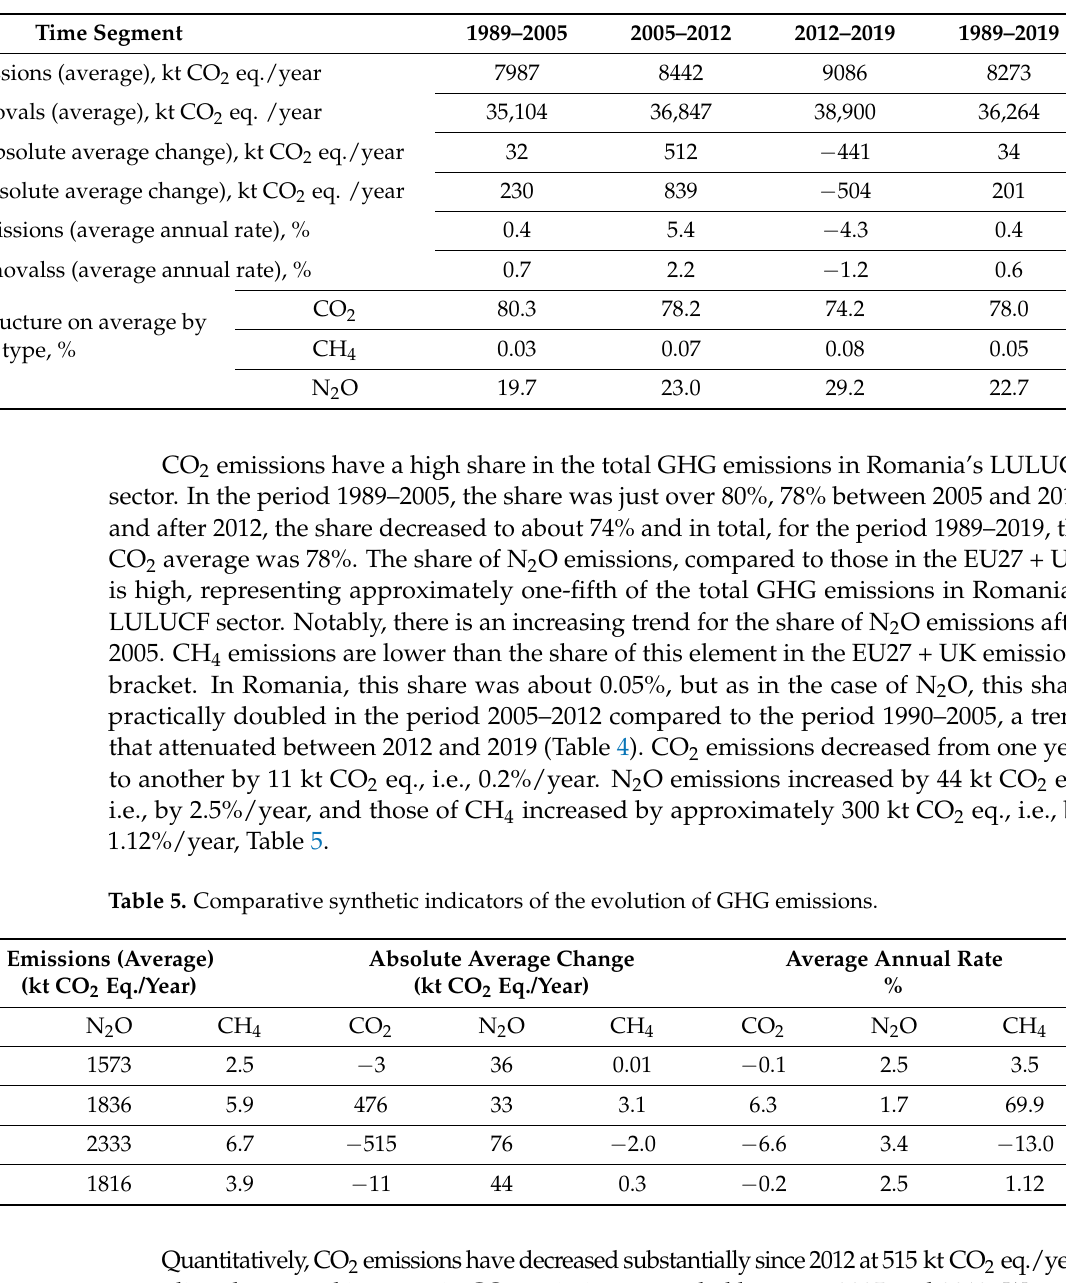
Table 4. Romania’s GHG emissions vs. GHG removals. Comparative synthetic indicators evolution.